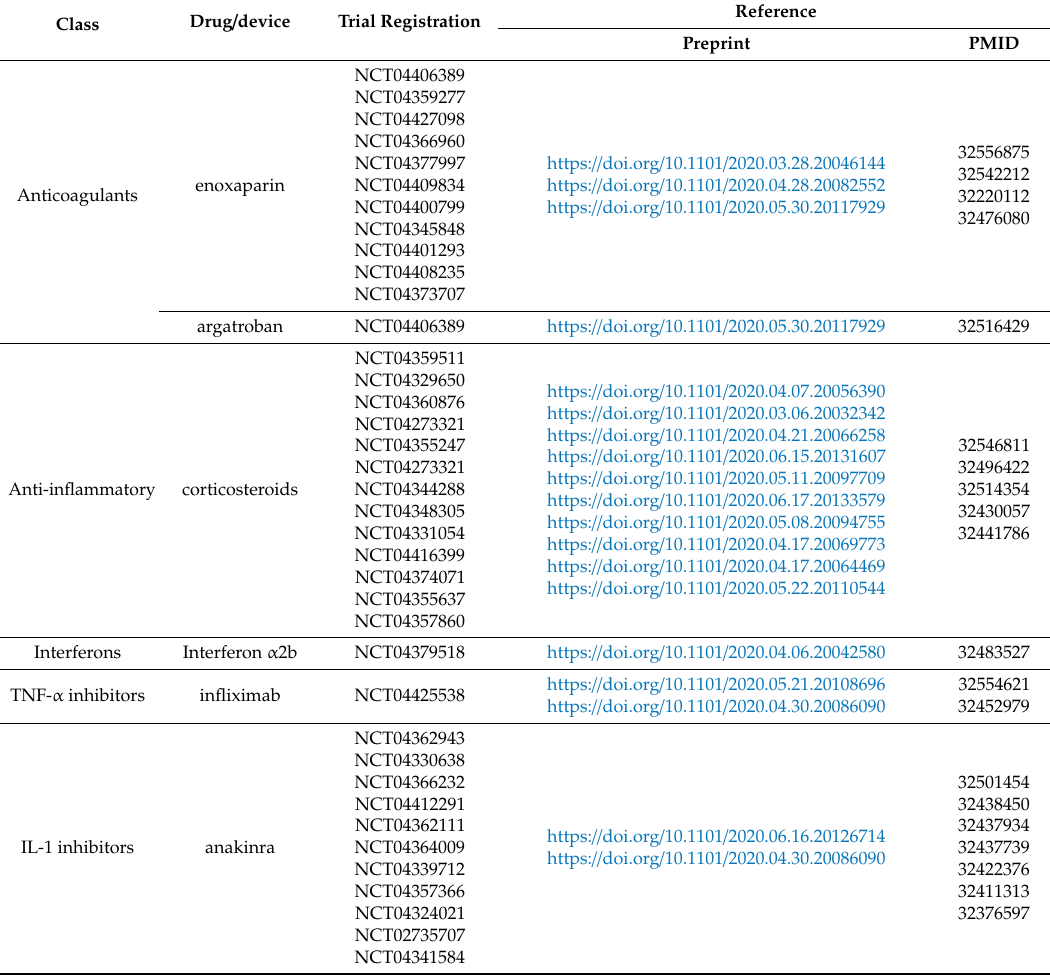
Table 2. Investigational treatments with potential impact on vascular manifestations of